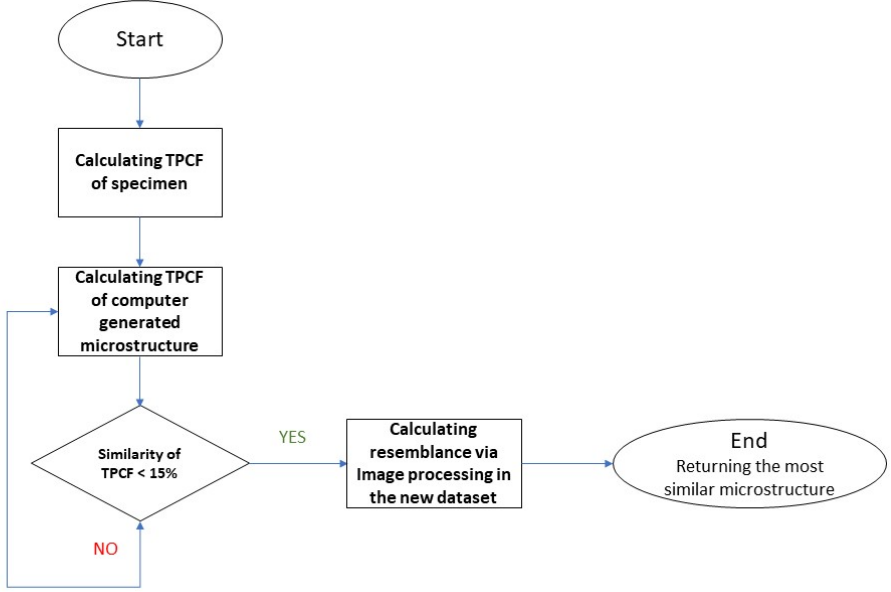
Figure 8. ( Top ) Perpendicular cut-section images of the experimental microstructure; ( Bottom ) the best match in our computational dataset found by the Figure 8 algorithm.